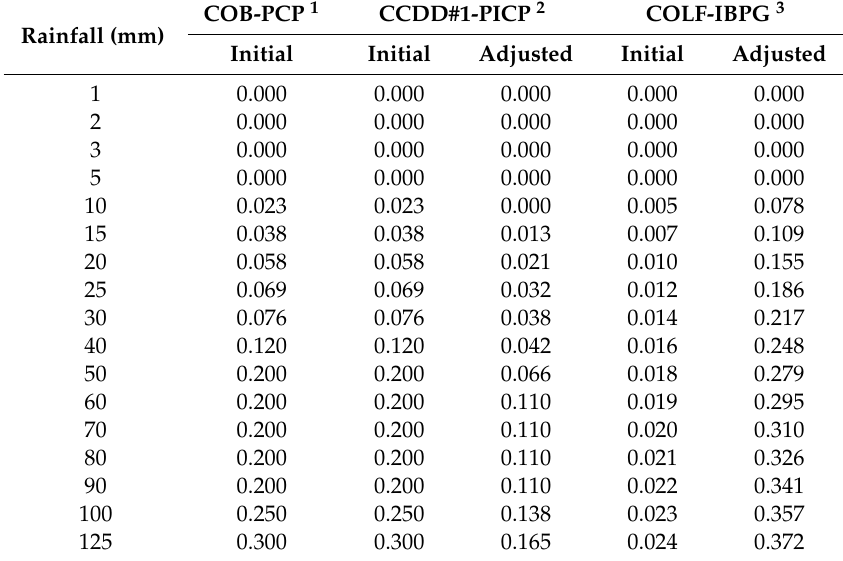
Initial and calibrated runo ff coe ffi cient values used for pervious surfaces of permeable